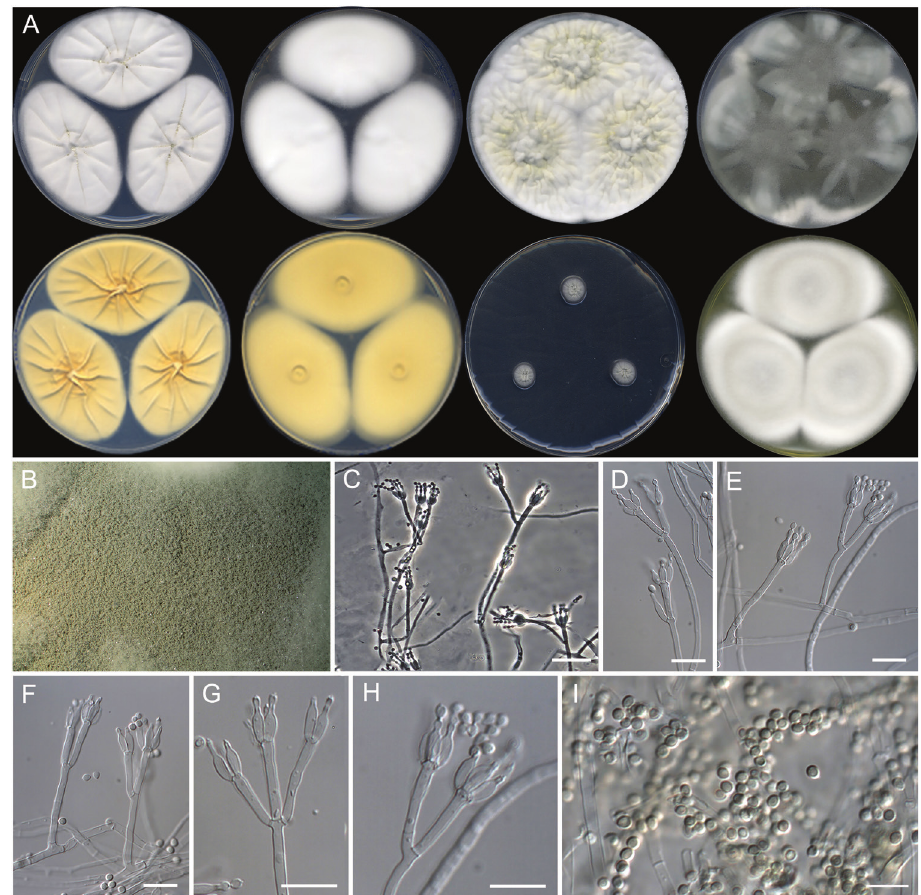
Figure 9. Morphological characters of Penicillium ausonanum sp. nov. (ex-type FMR 16948). A colo- nies from left to right (top row) CYA, MEA, YES, and OA; (bottom row) CYA reverse, MEA reverse, DG18, and CREA B colony on OA under stereoscopic magnifying glass C–H conidiophores I conidia. Scale Bars: 25 μm ( C ), 10 μm ( D–I